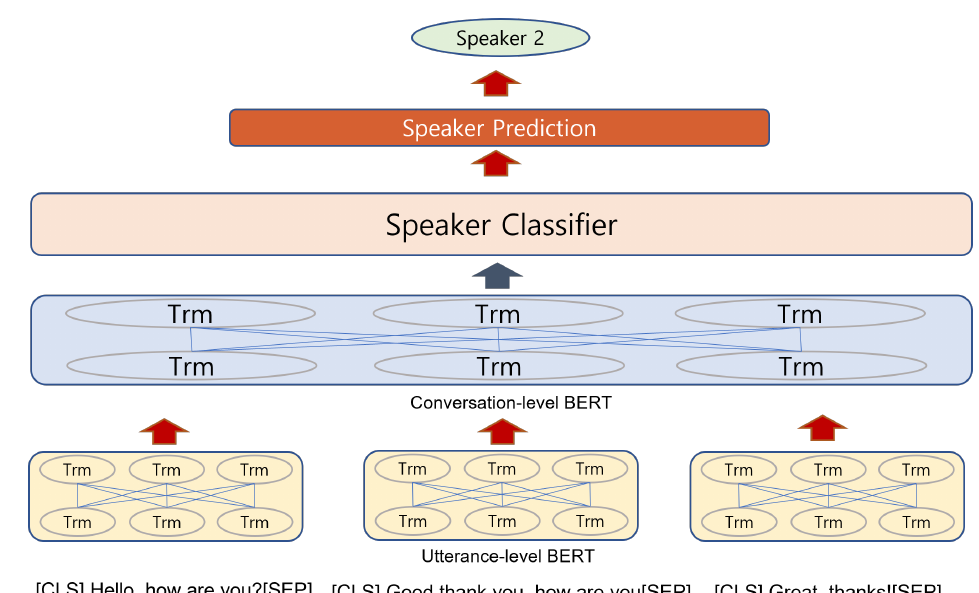
Figure 6. Overview of Speaker Classification. The model is trained to predict the true speaker on speaker-masked utterance using the context-encoded utterance and speaker classifier; TRM = Transformer